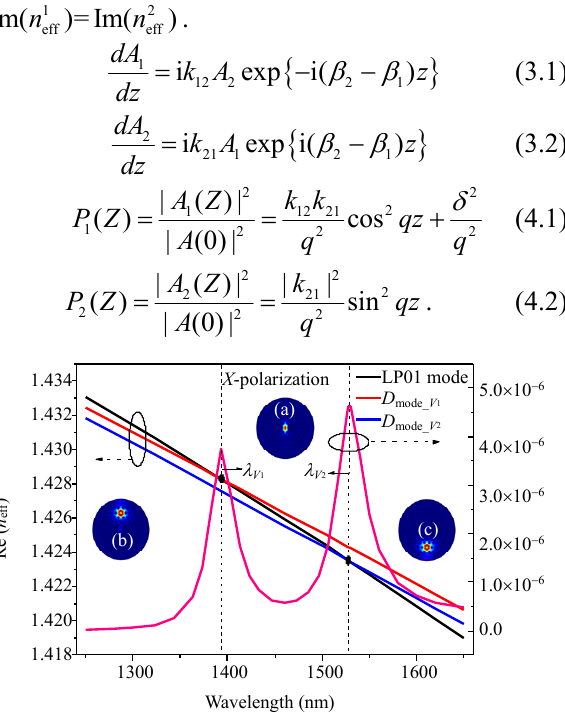
Fig. 2 Curves of effective RIs of LP 01 mode, D dependent on wavelength and the illustrations 2 mode_ V representing the optical field distribution of different modes at 1480 nm 